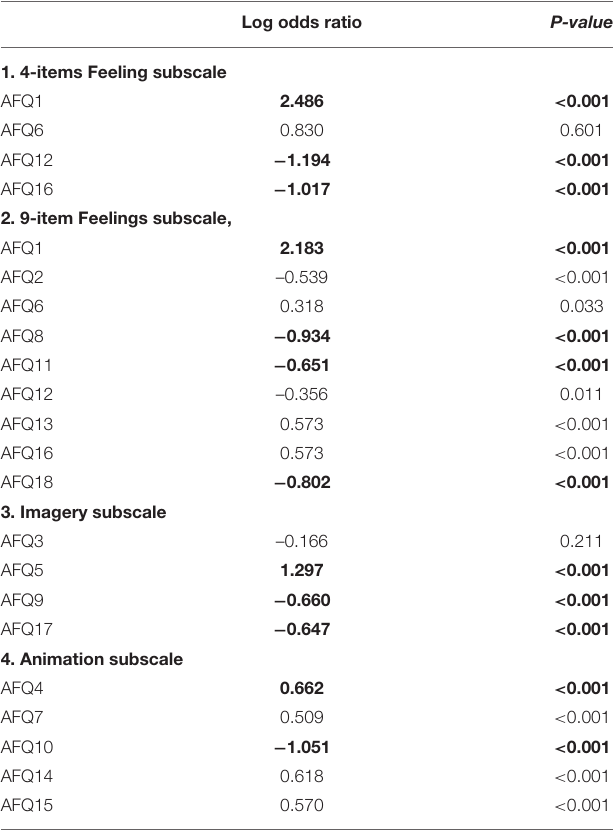
TABLE 4 | Differential Item Functioning for items on each subscale, controlling for total scores, age, and gender. Log odds ratio